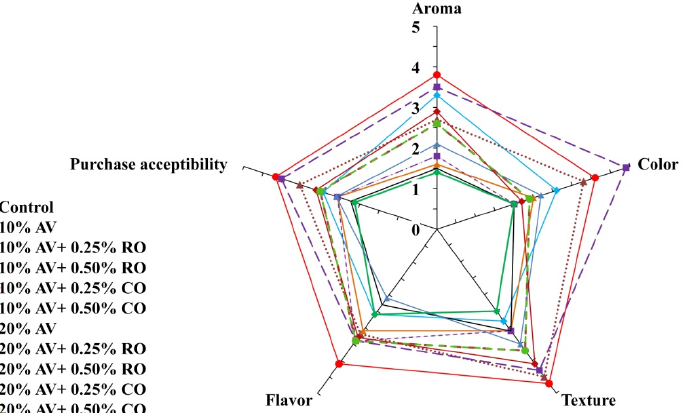
Figure 9. Sensory attributes (flavor, texture, color, aroma, and purchase acceptability) of ‘Bhagwa’ pomegranate arils that were coated with Aloe vera (AV) gel coatings that were enriched with rosehip oil (RO) (0.25% or 0.50%) and cinnamon oil (CO) (0.25% or 0.50%) and stored at 5 ± 1 °C (95 ± 2% RH) for 15 days. The data were captured after 9 days of storage during the 15 days trials due to safety precautions. The vertical bars represent the standard deviation (SD) of the mean values of three replicates (1 punnet = 1 replicate, n = 3). The data are expressed as the mean ± SD ( n = 3).